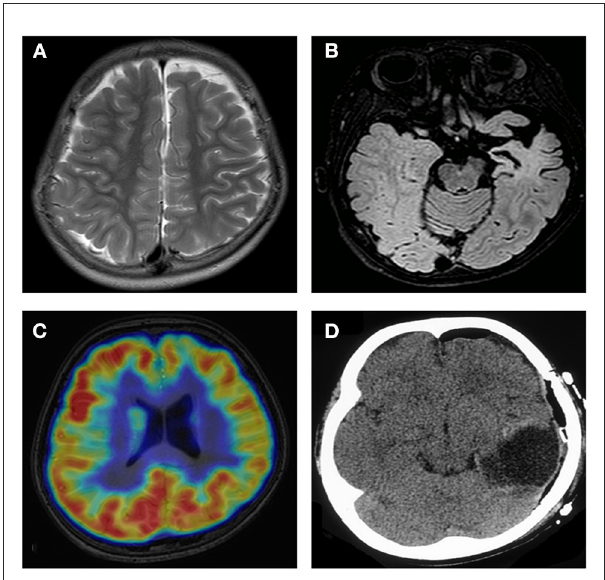
FIGURE4 Neuroimaging data of case 4. MRI shows mild atrophy in the left hemisphere (A) . MRI reveals encephalomalacia in the left temporal lobe (B) . PET shows hypometabolism in the frontal and parietal lobes (C) . Imaging shows completed left temporal lobectomy (D)